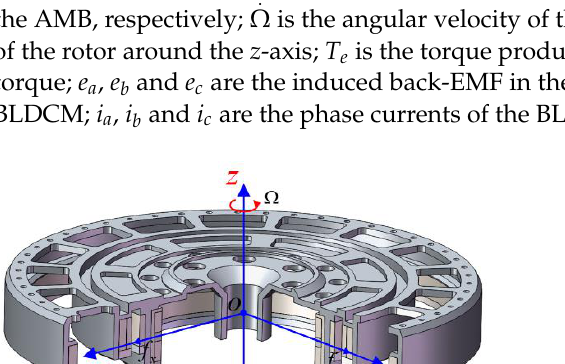
Figure 1. Structure of the MLRW.